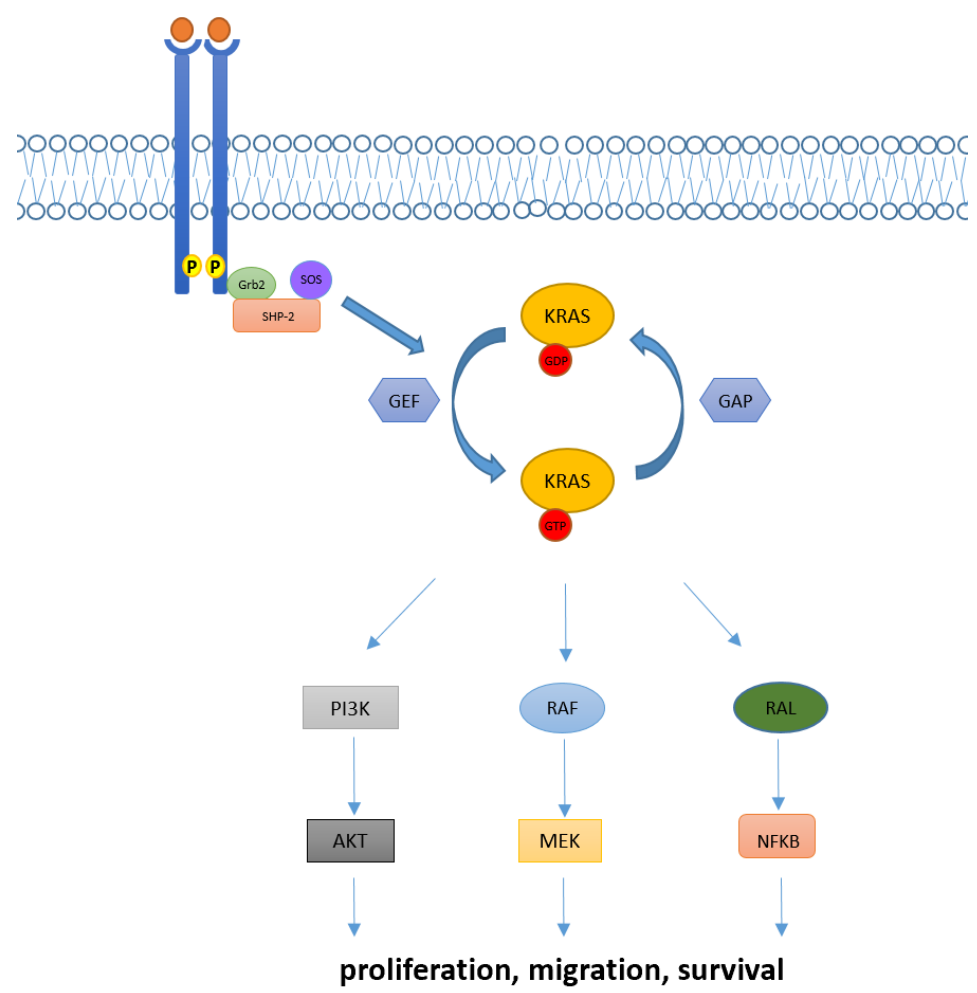
Figure 1. KRAS activation and its downstream pathway. KRAS proteins are key elements in trans- ducing extracellular signaling to downstream pathways. Intracellular KRAS proteins may present in two functional forms, KRAS-GTP and KRAS-GDP, which correspond to their active and inactive state, respectively. Transition from the KRAS-GDP to KRAS-GTP binding state is usually mediated by GEFs proteins and occurs via other adaptor and recruiter proteins, such as Grb2 and SHP-2. Conversely, transition from KRAS-GDP to KRAS-GTP usually requires GAPs proteins. Downstream signaling of KRAS normally includes RAF-MEK-ERK, PI3K/AKT and RAL pathways, implied in the regulation of cellular proliferation, migration, and death.